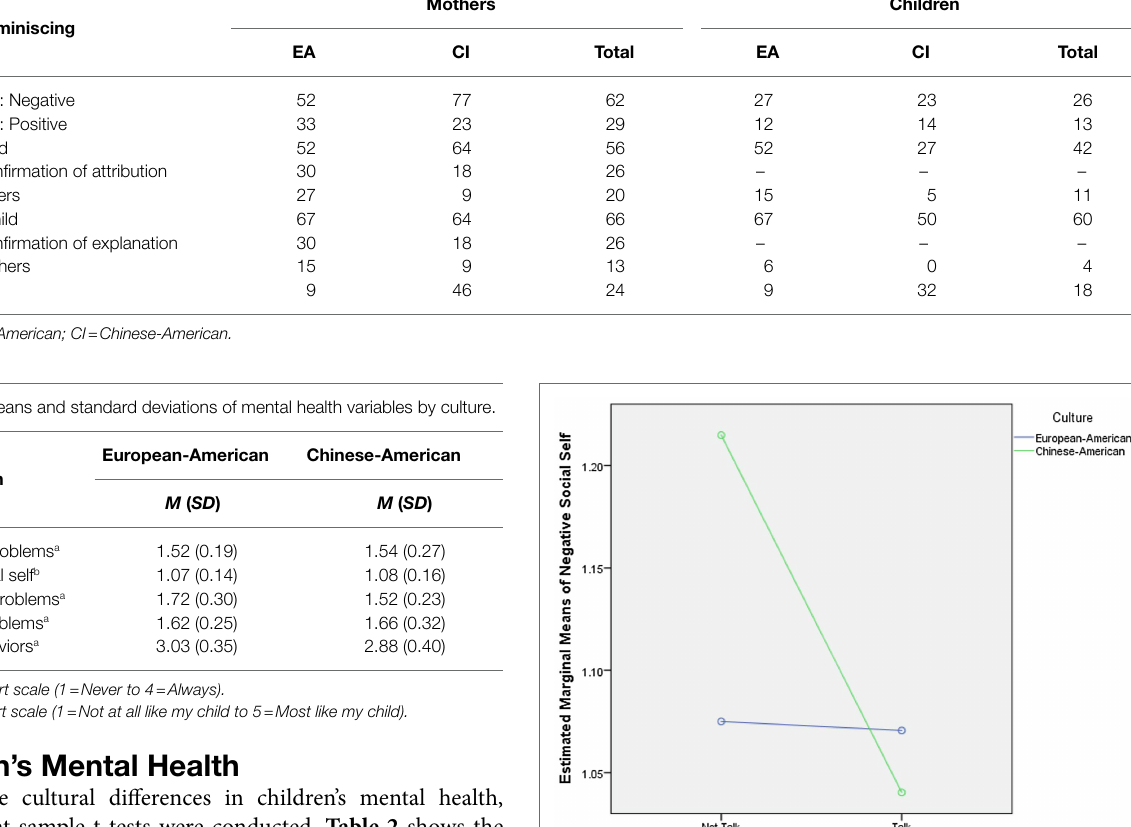
TABLE 1 | Percentages of mothers and children who provided responses for the emotion talk variables by culture. Emotional reminiscing